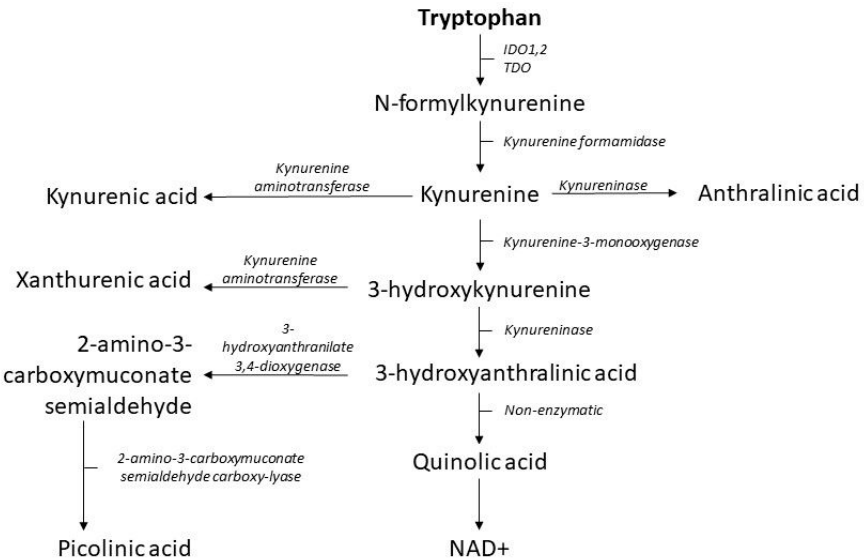
Figure 2. Kynurenine pathway Abbreviations: IDO; indoleamine 2-3-dioxygenase, TDO; tryptophan 2,3-dioxygenase.